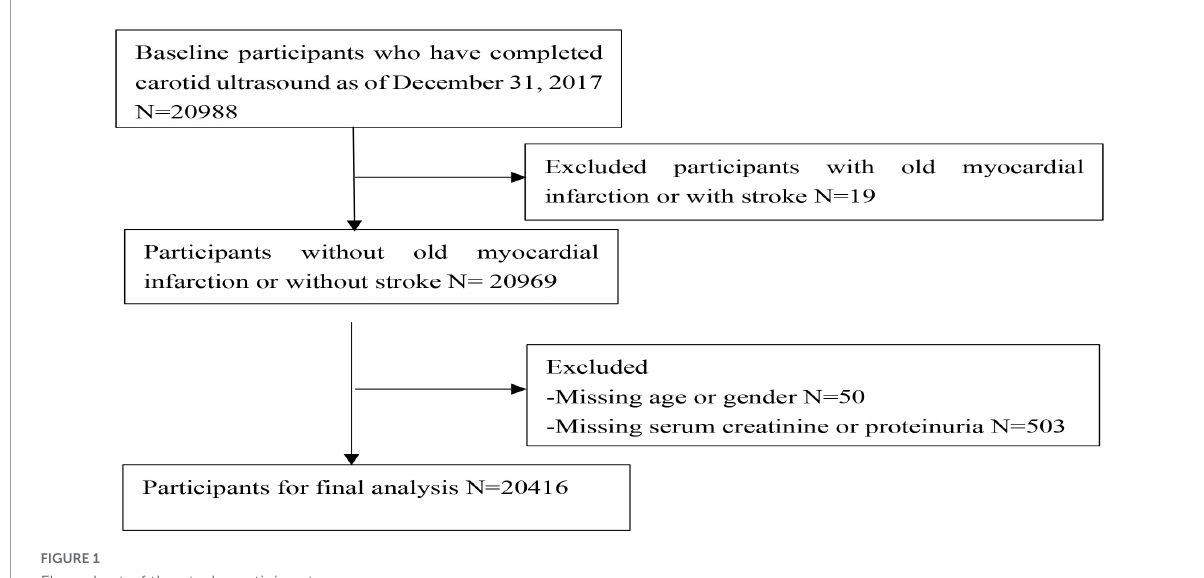
FIGURE1 Flow chart of the study